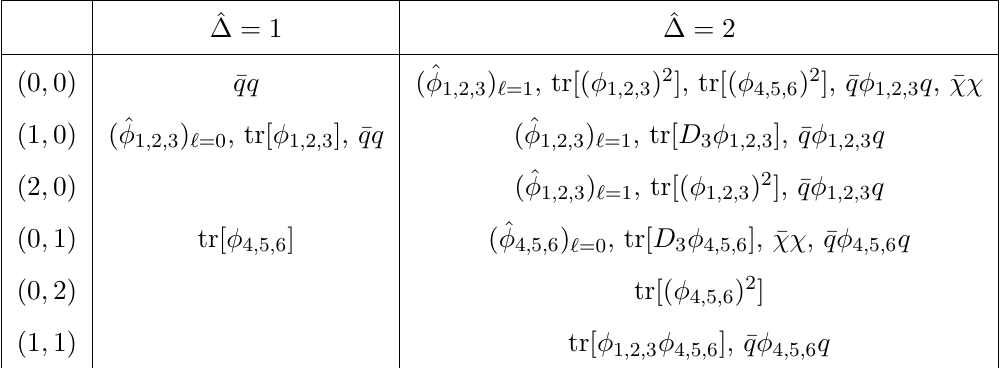
Table 4 . Scalar single-trace operators with ^(cid:1) = 1 ; 2. For brevity we leave out the explicit group- k > 2. Note that (1 ; 0) occurs twice in the decomposition of (cid:22) q(cid:30) 1 ; 2 ; 3 q .